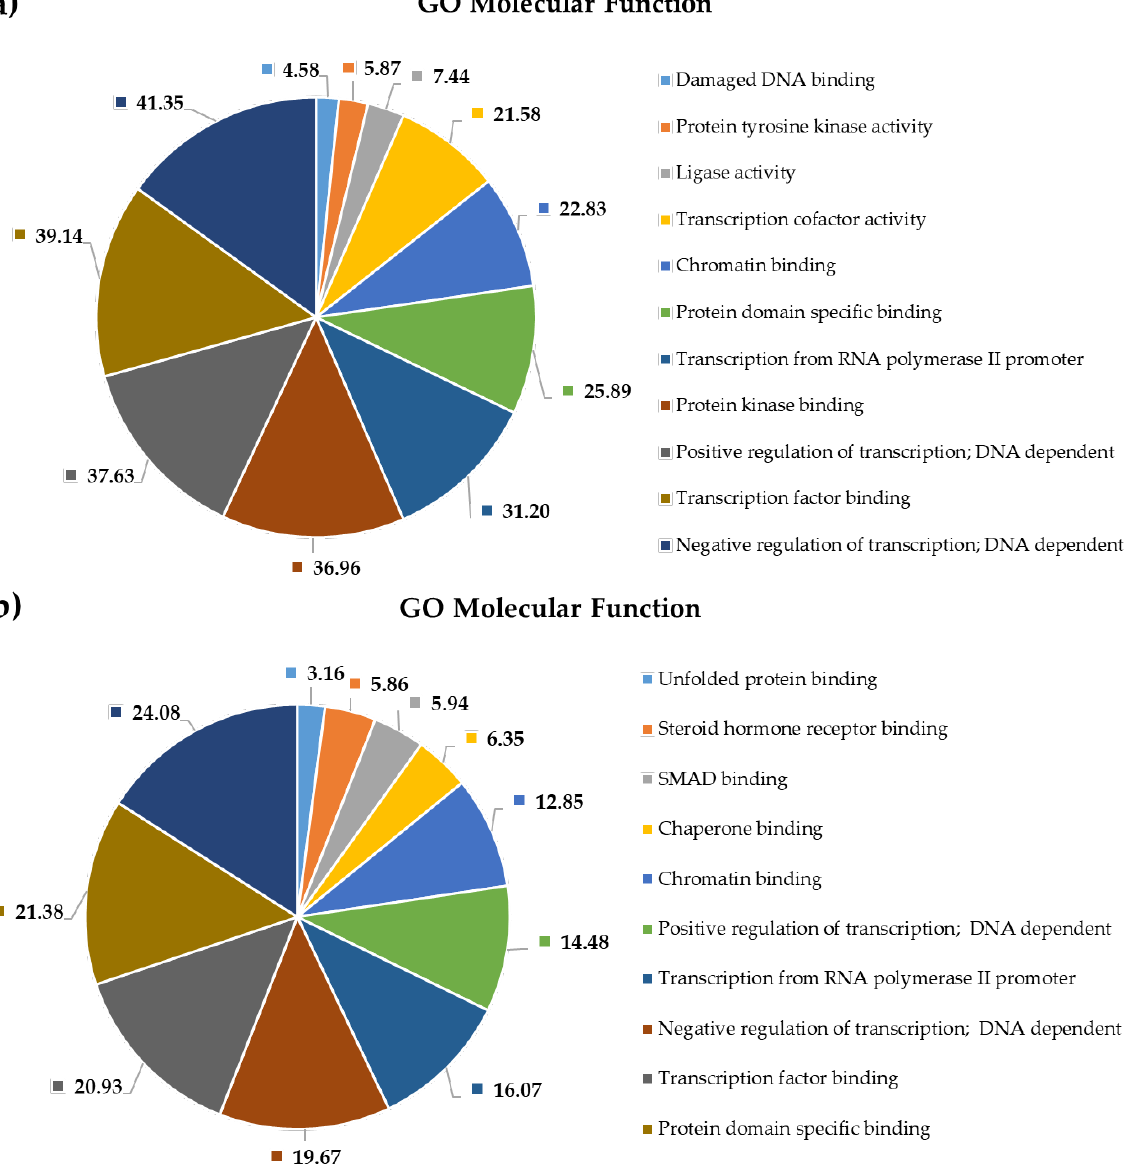
Figure 9. GO molecular function–based general ( a ) and cortex-specific ( b ) functional enrichment annotation of all target genes of differentially expressed miRNAs applying the NetworkAnalyst tool. Significance of the selected (?) pathways are characterized by their FDR values shown inside the chart sections.